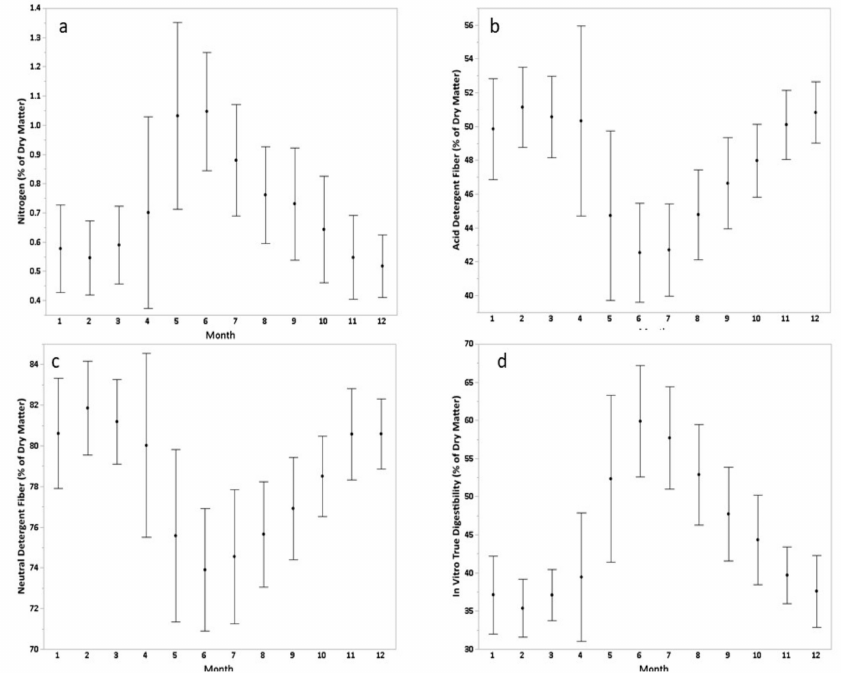
Figure 4. Monthly mean concentrations of ( a ) total nitrogen, ( b ) acid detergent fiber, ( c ) neutral detergent fiber, and ( d ) in vitro true dry matter digestibility of standing biomass. Error bars are ± 1 standard deviation. Month 1 = January ... Month 12 =